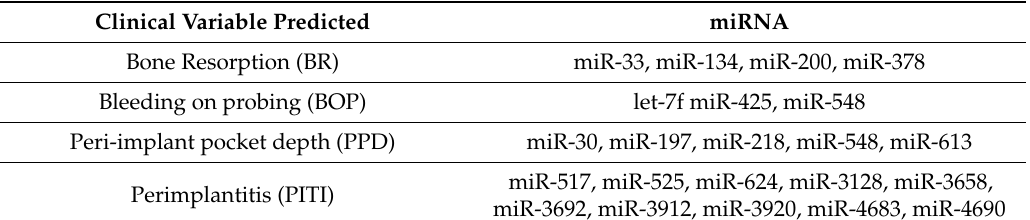
Table 2. Identity of miRNAs predictor of five-year clinical outcomes of dental